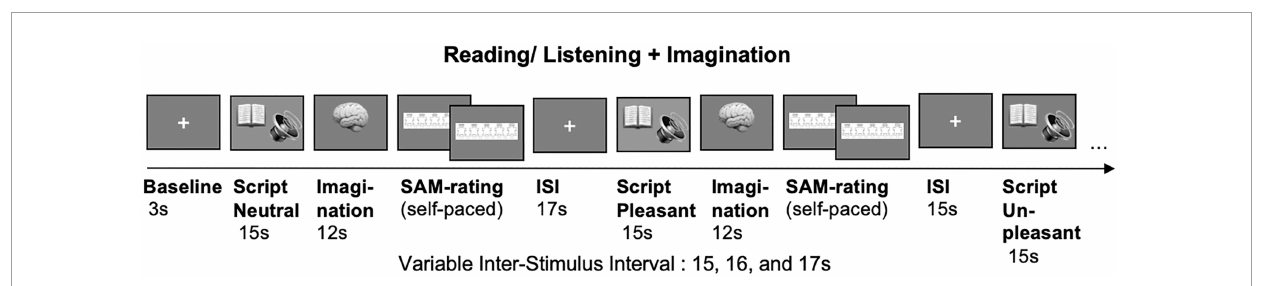
FIGURE2 Imagination task. Unpleasant (U), neutral (N) and pleasant (P) scripts are presented for 15 s (listening/reading), followed by a 12 s imagination period and the self-paced Self-Assessment Manikin (SAM) rating. Variable inter-stimulus interval (ISI) of 15, 16, and 17